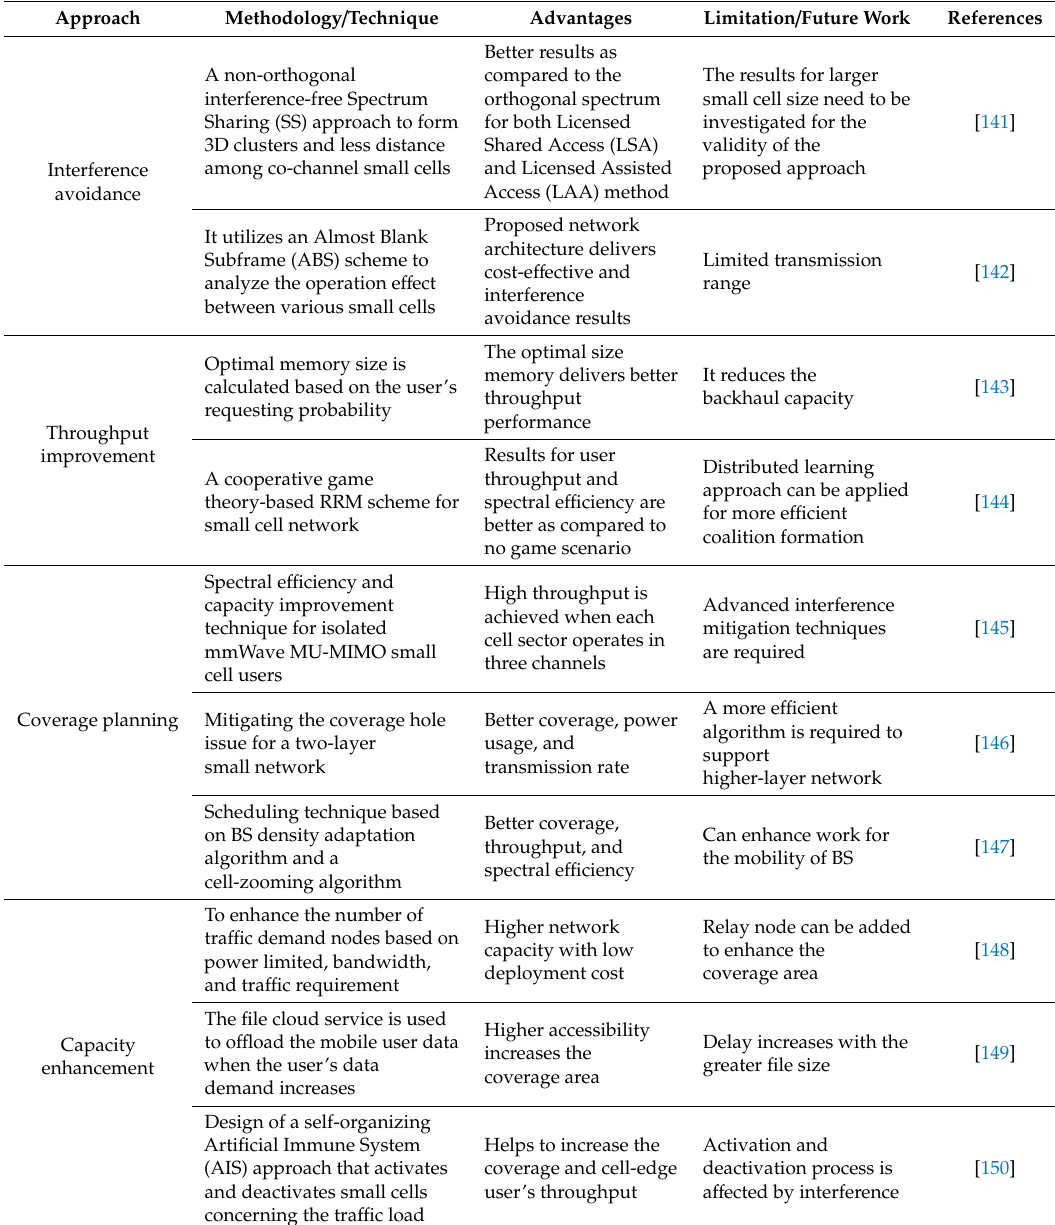
Table 3. Summary of the related work for the small cell-based